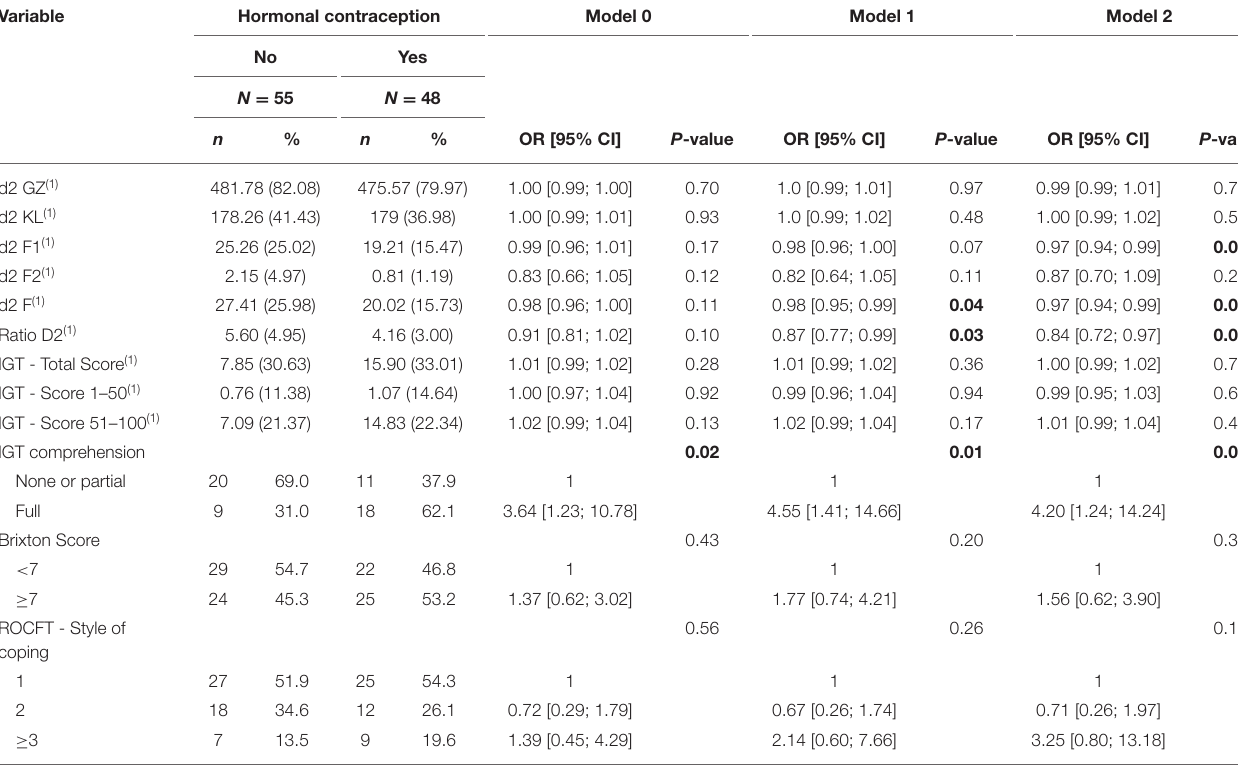
TABLE 2 | Association between the neuropsychological test scores and hormonal contraception use.